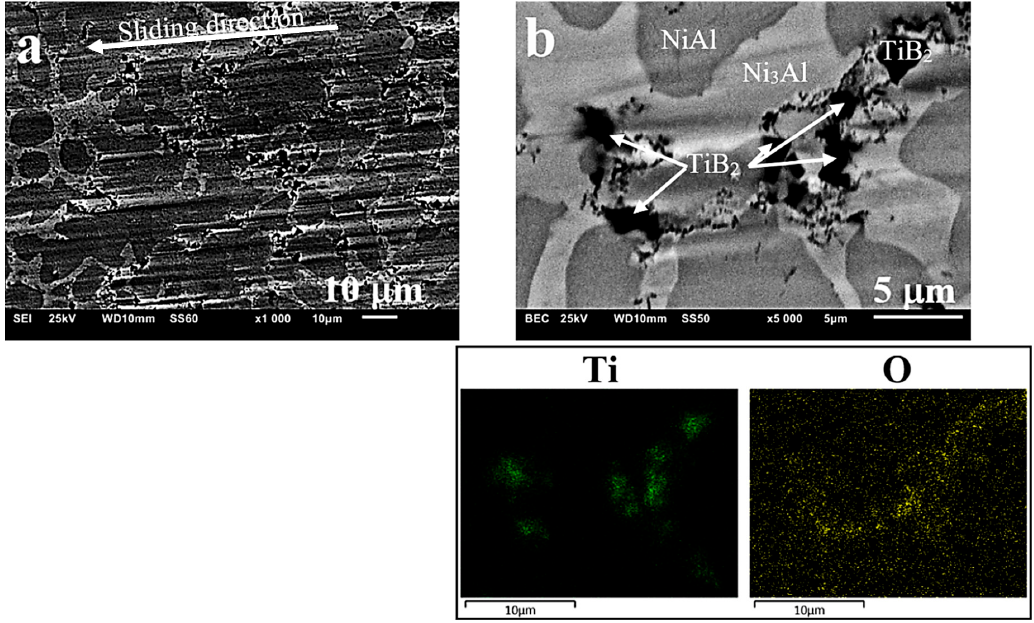
Figure 12. Composite surface after the ball-on-disc friction process; ( a ) surface degradation with TiB 2 particles removed, ( b ) embedded TiB 2 particles and oxidized products (oxides formed)—EDS analysis.